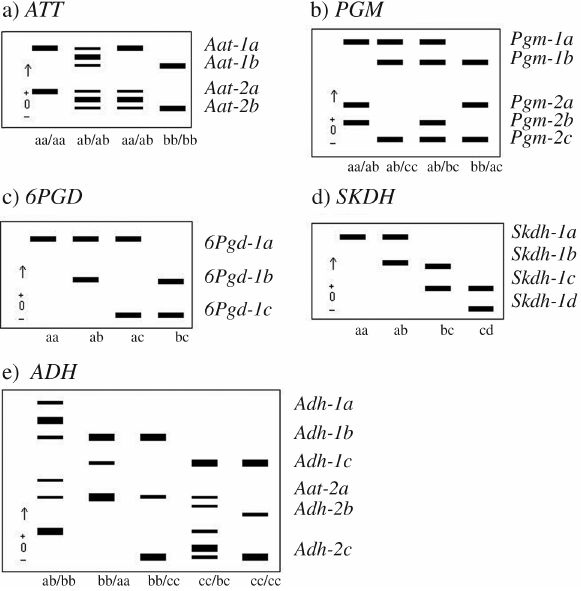
Figure 1 - The electrophoretic phenotypes and corresponding genotypes for five enzyme systems used to analyze the mating system in populations of Senna multijuga